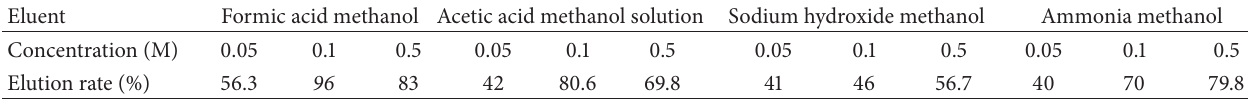
Table 1: Elution rate of TBT from Fe 3 O 4 @MIPs with different pH concentrations of eluents.